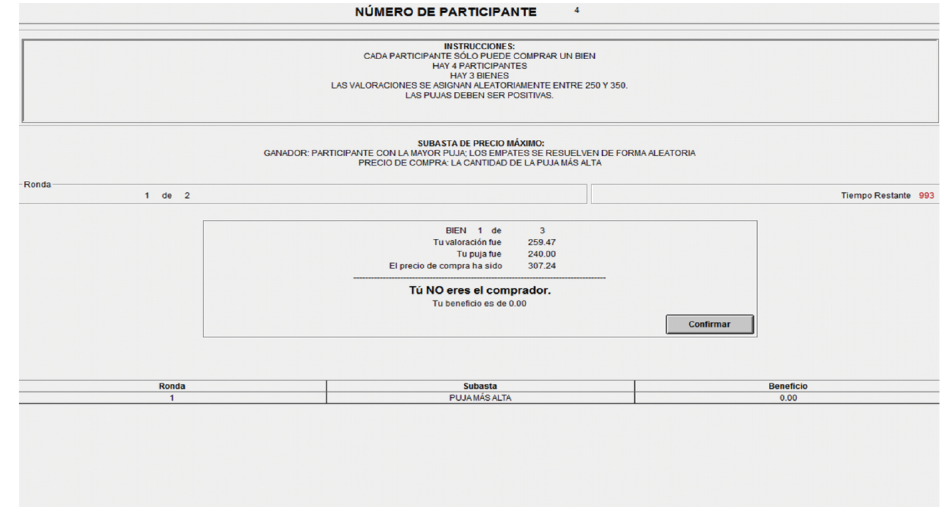
Figure A1.5. Non-winner of